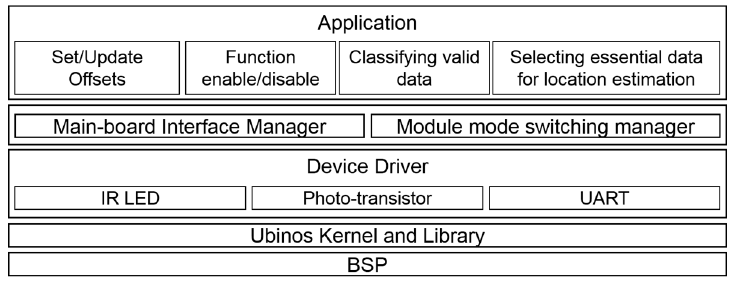
Figure 17. Software architecture of infrared communication module.